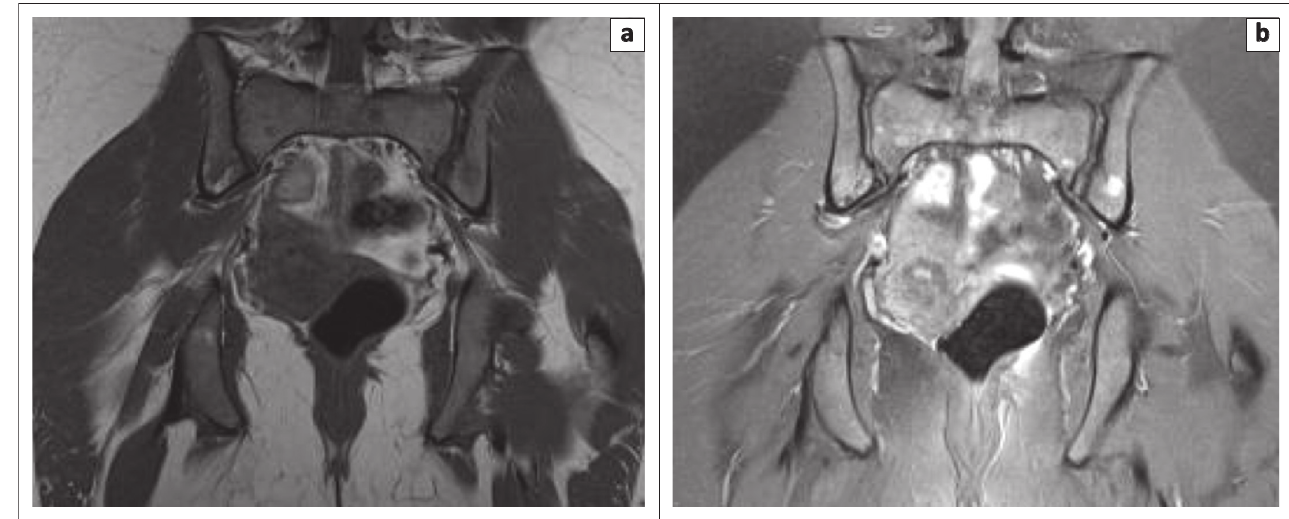
FIGURE 5: Coronal T1-weighted MR image (a) of the pelvis, and coronal PD MR image (b) of the pelvis.